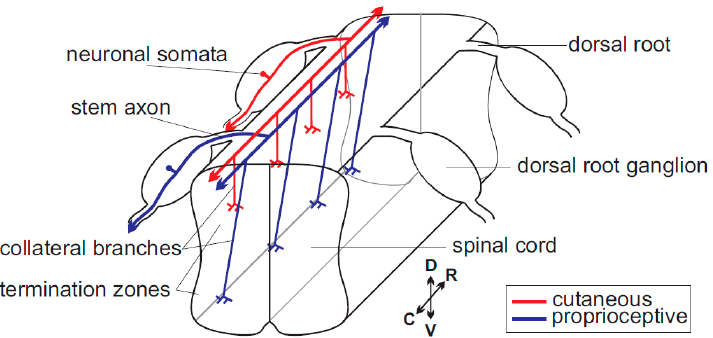
Figure 1. Scheme of the path of sensory axons within the spinal cord. A single cutaneous (red) and single proprioceptive (blue) neuron are highlighted. C, caudal; D, dorsal; R, rostral; and V, ventral. Sensory axons enter the spinal cord at early embryonic stages at the dorsal root entry zone (DREZ), where they split into ascending and descending arms [35–38]. These two stem axons grow over several segments along the lateral margin of the cord. Subsequently, axon collaterals branch off from these stem axons (also termed interstitial branching) and grow in ventral direction. Nociceptive and mechanoreceptive collaterals terminate in dorsal layers of the spinal cord, where further terminal branching takes place to establish contacts to dorsal horn neurons. Proprioceptive collaterals extend into ventral parts of the spinal cord including the Clarke column at lower spinal levels and further branch to form synapses on motor neurons or interneurons. Taken together, a relative simple pattern of axon branching is executed by sensory axons within the spinal cord with three major types of branching modes (Figure 2): (A) bifurcation at the DREZ; (B) collateral branching from stem axons; and (C) terminal branching of collaterals in termination zones [39,40]. Images of individual sensory axons when entering the spinal cord at the DREZ indicated that bifurcation is mediated by splitting of the growth cone. In contrast, collateral formation proceeds from the shaft of the two resulting